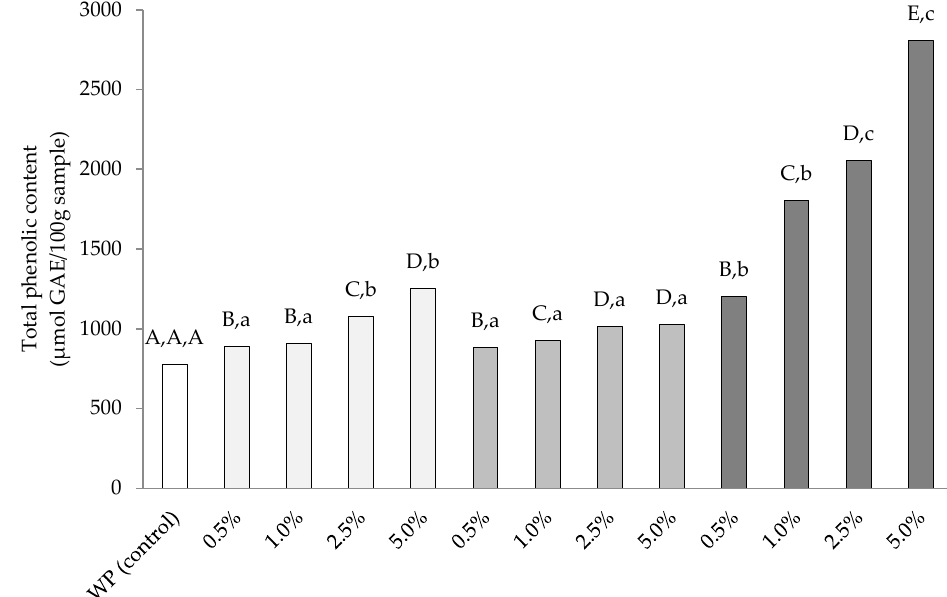
Figure 3. Total phenolic content of whey protein modified with different oxidized phenolic com- pounds at various concentrations. Different letters in the same concentration of oxidized phenolic compounds indicate significant differences. Different capital letters in the same type of oxidized phenolic compounds and control indicate significant differences.